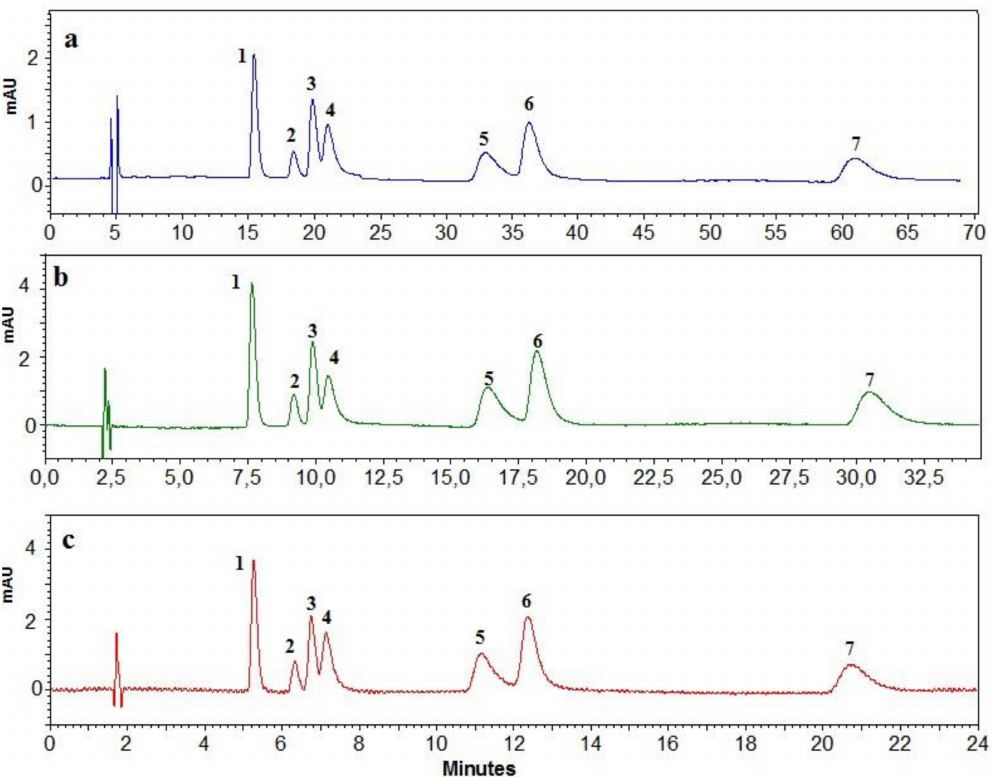
Figure 4. Example of a chromatogram obtained using three monolithic columns and a flow rate of 1( a ), 2( b ) and 3( c ) mL / min. Mobile phase composed of acetonitrile and a 15 mM aqueous solution of ammonium acetate adjusted with acetic acid to pH 4 (2:8, v / v): 1—protopine; 2—allocryptopine; 3—chelidonine; 4—coptisine; 5—sanguinarine; 6—berberine; and